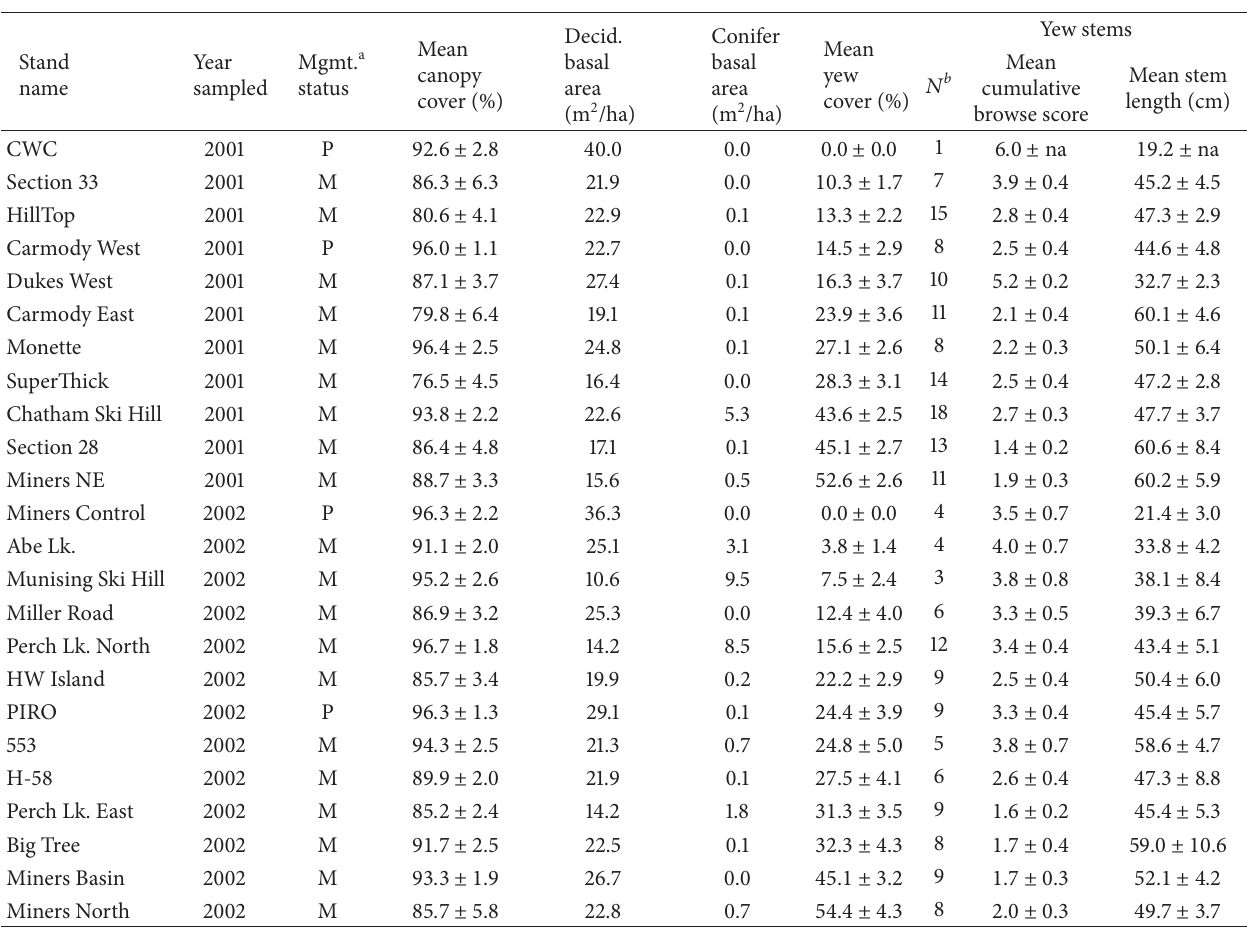
Table 1: Characteristics of 24 forested stands sampled for Canada yew browse in 2001-2002 in Marquette and Alger counties, Michigan, USA. Only those stands with at least one cluster of ≥ 3 live stems were included in model selection analyses and are shown below.